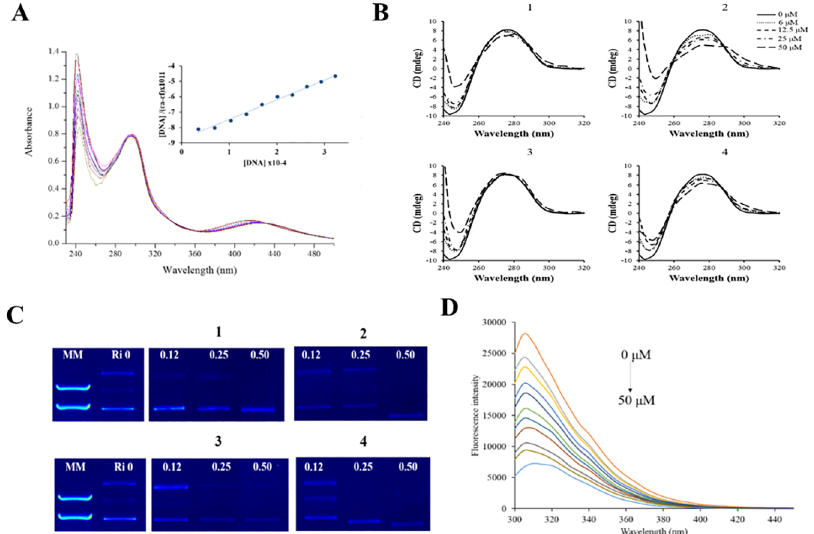
Fig 6. Absorption spectral titration. (A) Absorption spectral titration of complex (4) in the presenceof increasing concentrations of ct -DNA at 298 K and fluorescence emissionspectra of HSA at 37˚C. Inset graph represents the plots of ( ε a - ε f )/( ε b - ε f ) versus [DNA] for the titration of DNA with Ru(II) complexes. (B) CD spectrum of ct -DNA (100 μ M) in the presenceof complexes (1–4) in Tris-HCl buffer after incubating by 18 h at 37˚C. (C) Electrophoretic mobility pattern of pBR322plasmid DNA incubatedwith metal complexes (1–4) by 18 h at 37˚C, at indicatedconcentrations ( μ M). Ri = ratio complex/DNA; MM = molecularmarker. (D) Fluorescence quenchingspectra of HSA with different concentrations of complex (4) with the excitation wavelengthat 270 nm at 37˚C in a Trizma buffer, pH 7.4. The arrow shows the intensity changesupon increasing the concentration of the quencher (0 to 50 μ M, orangeline to light blue line, respectively).